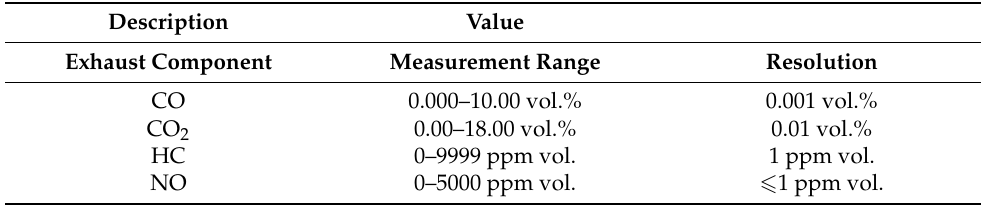
Table 2. Specification of the gas exhaust